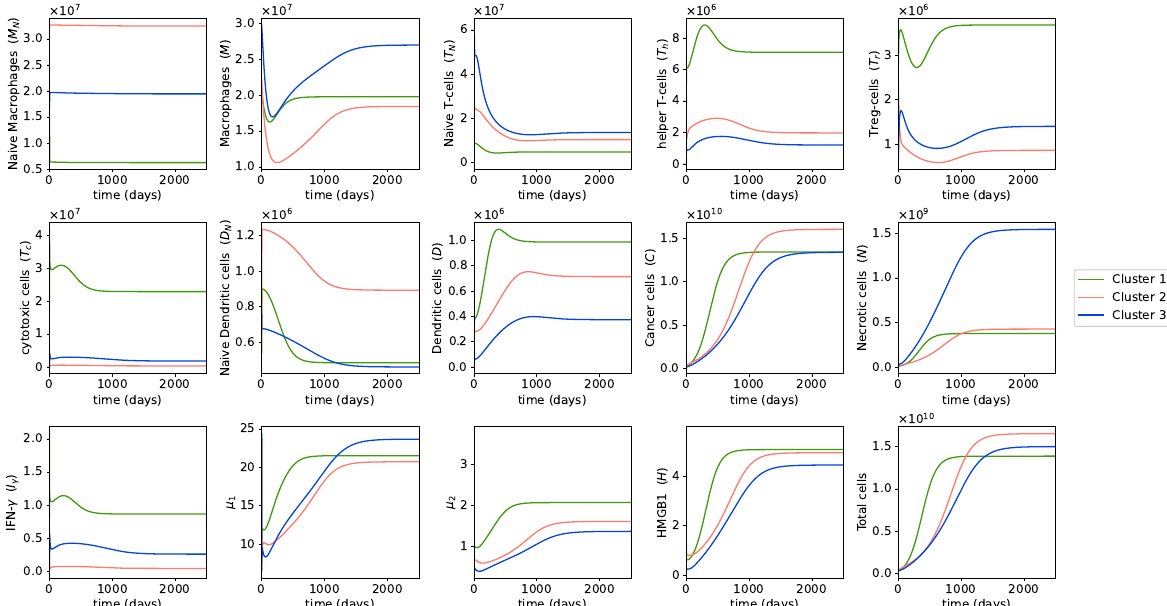
Figure 4. Dynamics of cells and cytokines in osteosarcoma tumors . Evolution of the cells and cytokine population in the model is plotted over the time in units of days. This figure shows the dynamics of the variables of the model starting from the time of the first diagnosis of small tumors in each cluster until reaching their steady state values, i.e., the average values of the largest tumors in the same cluster. The different color lines describe the dynamics of different